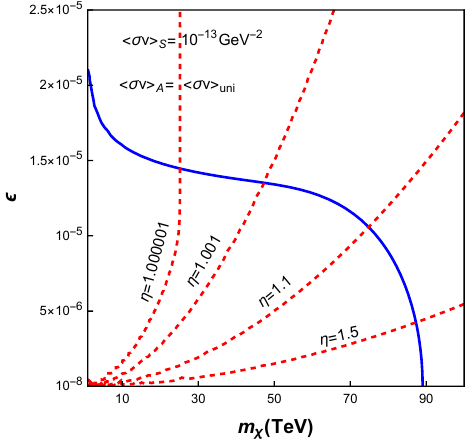
Figure 8 . Contours in the m (cid:31) (cid:10) h 2 = 0 : 12 is reproduced, with the pair-annihilation rate (cid:12)xed at its s-wave upper bound implied by S-matrix unitarity,